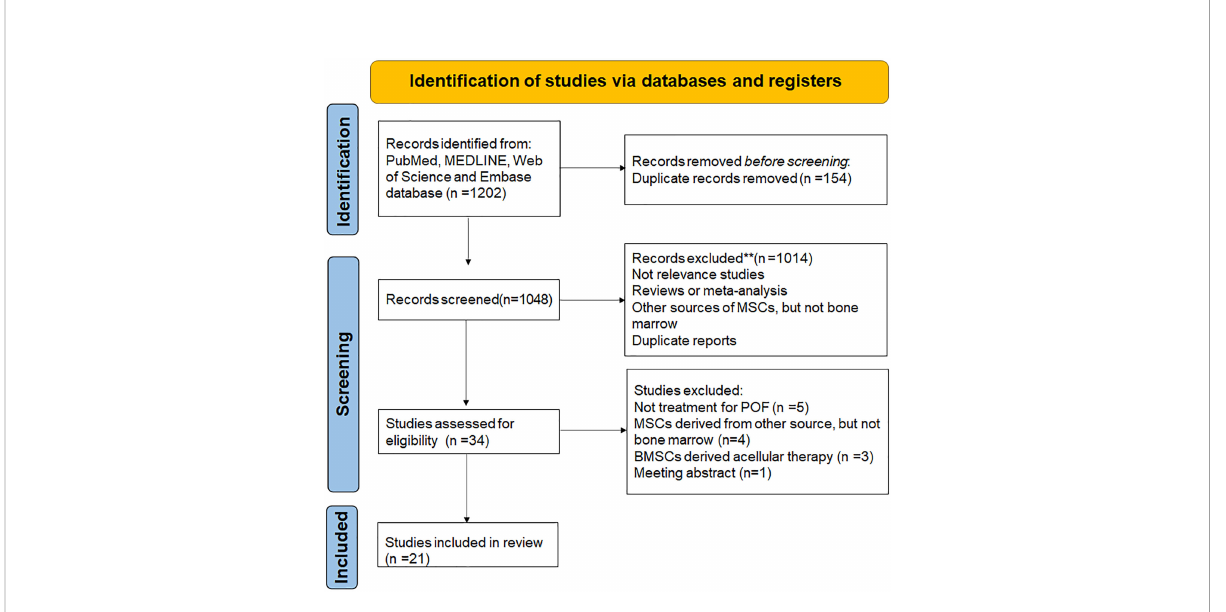
FIGURE 1 PRISMA fl ow